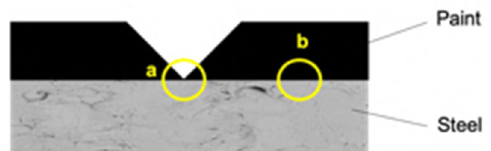
Figure 3. Scheme of the cross section of the coated specimens. Note: SEM-EDX analysis was carried out at ( a ) the scribe and at ( b ) non-scribed region . out at ( a ) the scribe and at ( b ) non-scribed